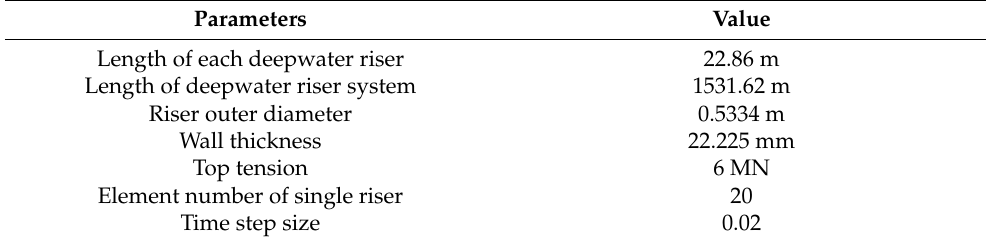
Table 1. Dynamic response analysis parameters.